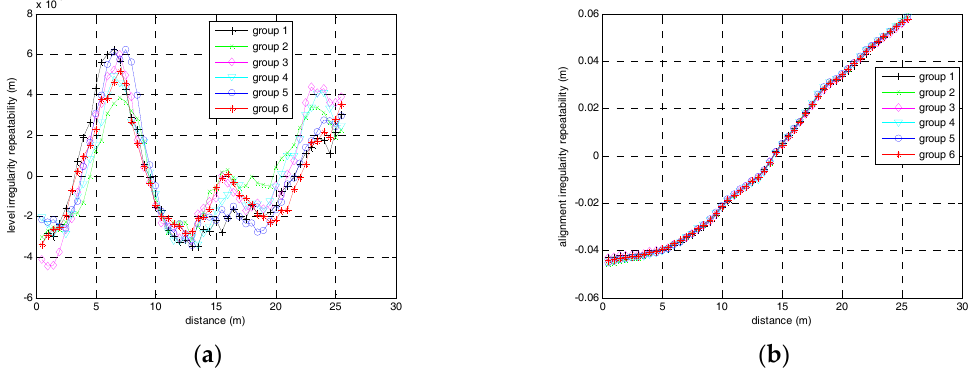
Figure 15. ( a ) Level irregularity measurement repeatability for 30 m chord; ( b ) Alignment irregularity measurement repeatability for 30 m chord.